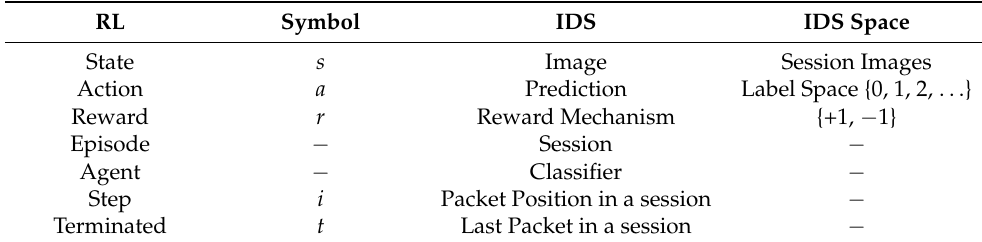
Table 4. Conversion of IDS to RL at Packet-level.